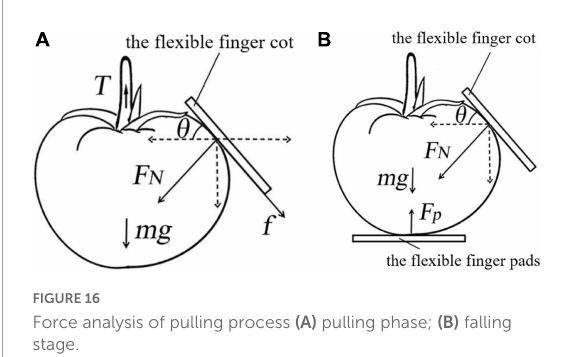
FIGURE16 Force analysis of pulling process (A) pulling phase; (B) falling